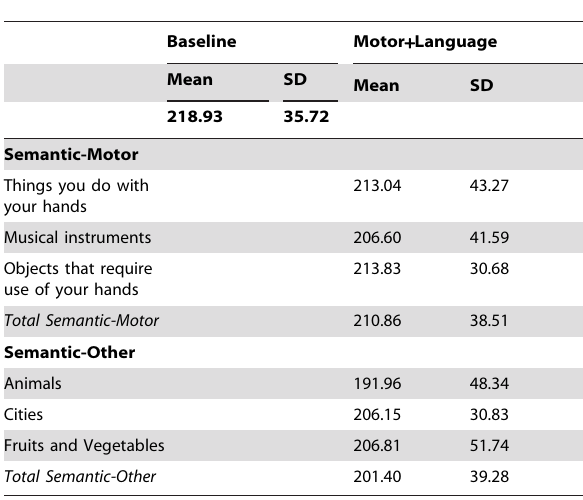
Table 3. Finger Tapping Means by Semantic